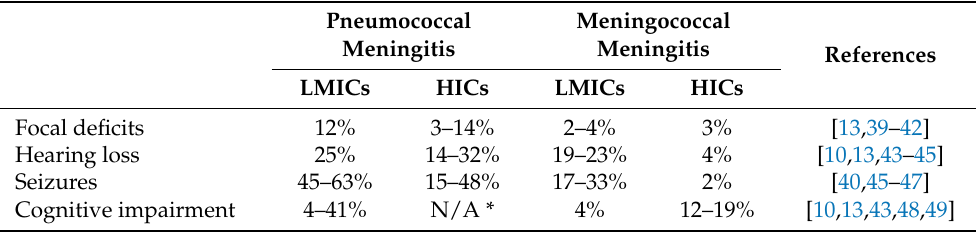
Table 2. Long and Short-term Neurological Complications following pneumococcal and meningococcal meningitis in Low and Middle Income Countries (LMICs) and High Income Countries (HICs).